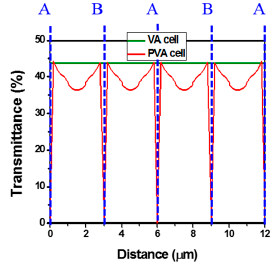
Figure 2. Calculated transmittance distribution in a PVA cell.